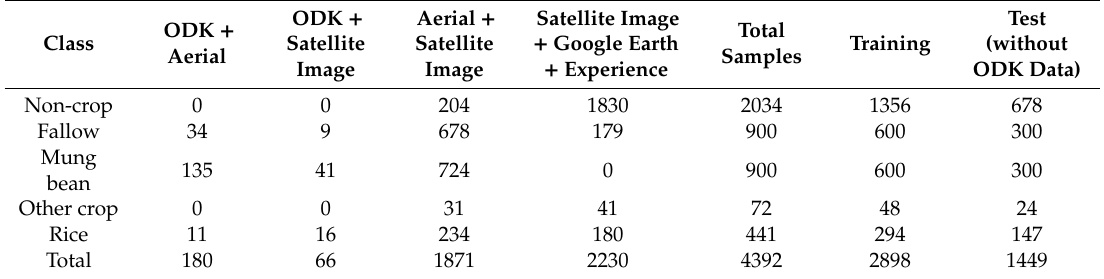
Table 2. Number of training and test samples for each class investigated. In-situ data that were collected in the field with the Open Data Kit (ODK) contain the term ODK in their